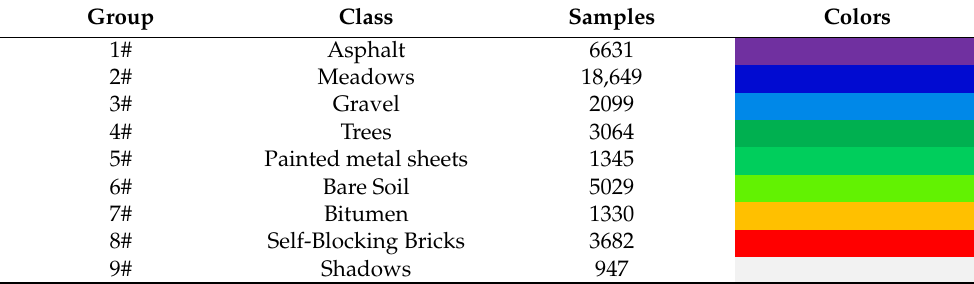
Table 10. Calibrated sample labels for the Pavia University data.